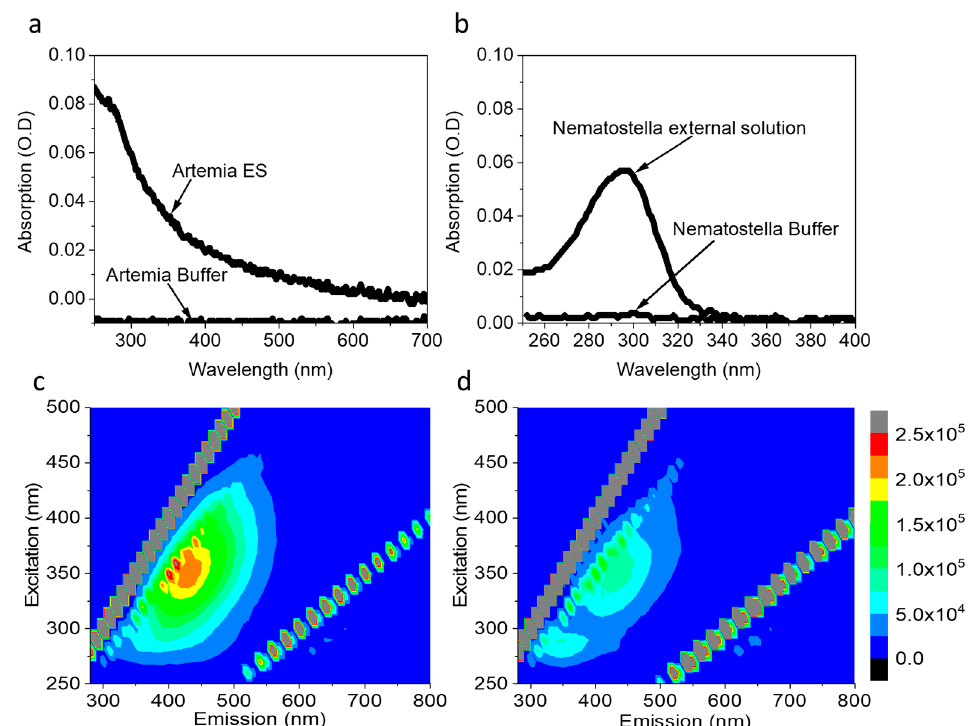
Figure 1. Artemia ’s eggs and Nematostella release molecules to the external solution, including NAD(P)H. ( a ) Absorption spectra of the pure buffer of Artemia and its external solution. ( b ) Absorp- tion spectra of the pure buffer of Nematostella and its external solution. ( c ) 2D-fluorescence spectra of the external solution of Artemia . ( d ) 2D-fluorescence spectra of the external solution of Nematostella . The lines of diagonal spots in all of the maps presented here and in the following figures result from the light scattering of the Xenon lamp and Raman scattering of the water [43].